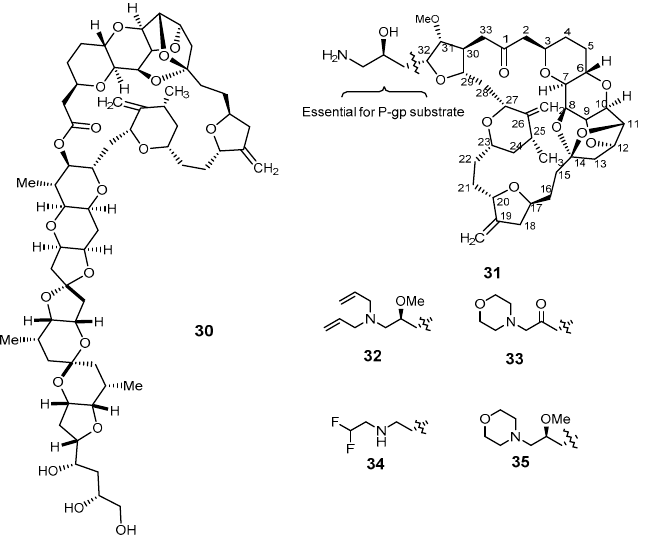
Figure 7. The structure of halichondrin B ( 30 ), eribulin ( 31 ), and the analogs 32 – 35 .